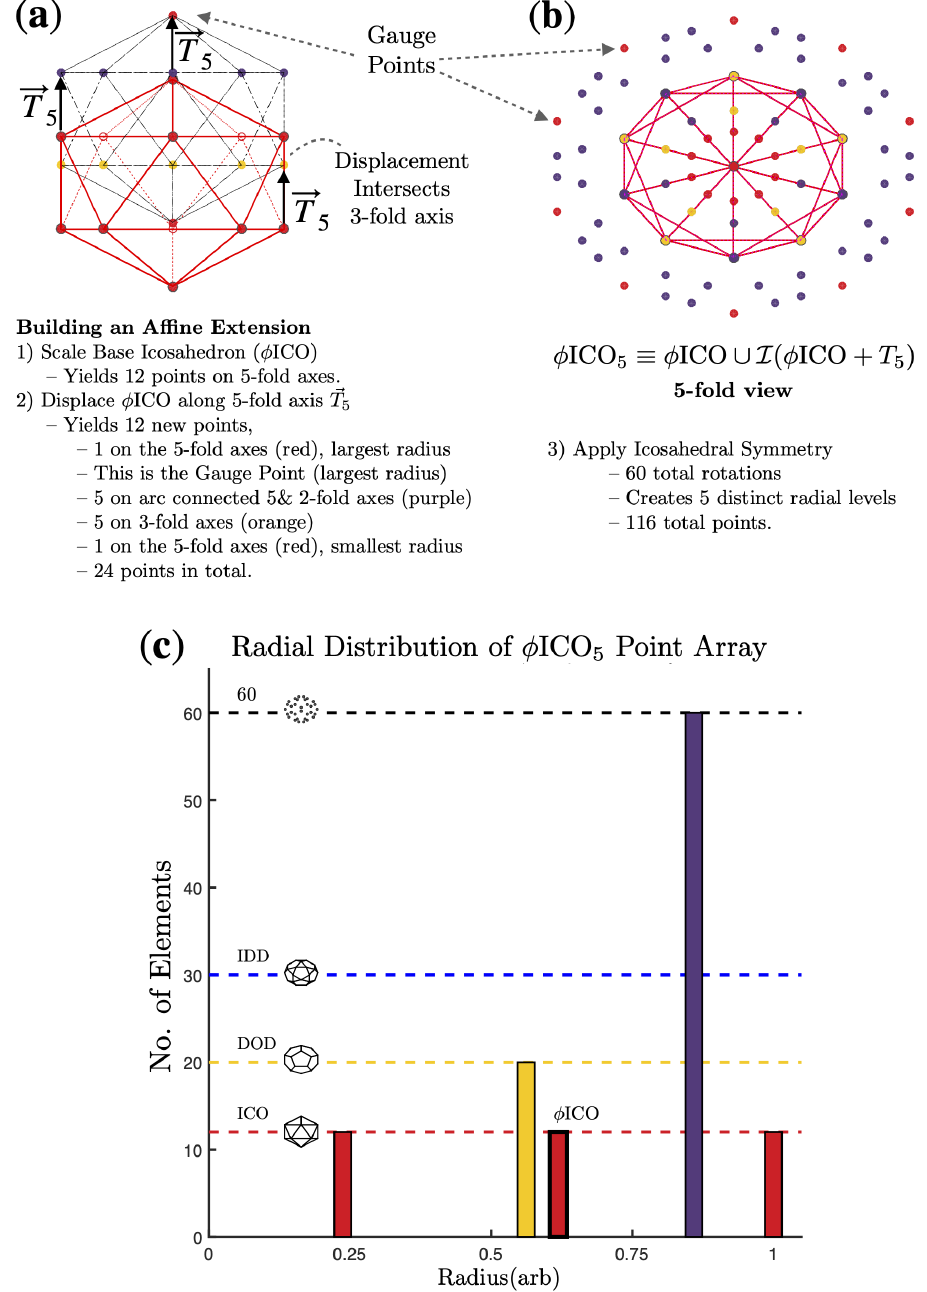
Figure 1. Point arrays are formed by performing an affine extension on the vertices of icosahedral polyhedra and then reapplying the rotation symmetry. The goal of this construction is to create representations of icosahedral symmetry at multiple radial levels in a mathematically consistent way, avoiding the formation of free groups [3–5]. We present all of our point array elements with the same color-mixing scheme. Red is 5-fold, blue is 2-fold, purple is directly between them. The 3-folds are yellow and between 3–5 is orange. Between 2–3 is green. Finally, any points not on the symmetry axes or the arcs connecting them are black. ( a ) The base icosahedron ICO is scaled by φ and then displaced along the 5-fold axis ( (cid:126) T 5 ) . This creates 12 new points, at 4 different radii. ( b ) We now apply icosahedral symmetry to the translated vertices, creating a new cloud of points which surround the base icosahedron. While the icosahedral group has 60 rotations, each translated point does not generate 60 new points. For instance, the gauge point, which is located on the 5-fold axis only yields 12 unique points upon application of the rotations. ( c ) The point array φ ICO 5 consists of 5 different radial levels with a gauge point on the 5-fold axes. The entire point array will be scaled so that the gauge points match the radius of the center of mass of the capsids protrusions [2]. The point cloud can be visualized as an outer icosahedron with a layer of 60 points between the 5 and 2 symmetry axes, along the face of the icosahedron, though at lower radius. Then inside of this surface is another icosahedron (base, r ∼ 0.64) that encloses a dodecahedron (DOD), which finally encloses a smaller icosahedron, at 24% of the radius of the gauge